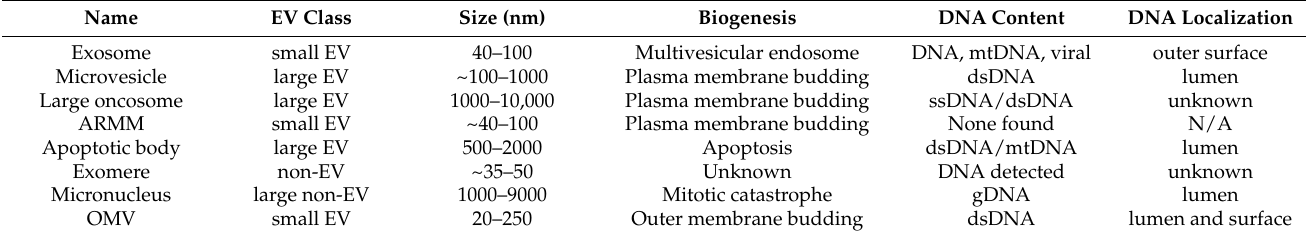
Table 2. Classifications of different types of extracellular